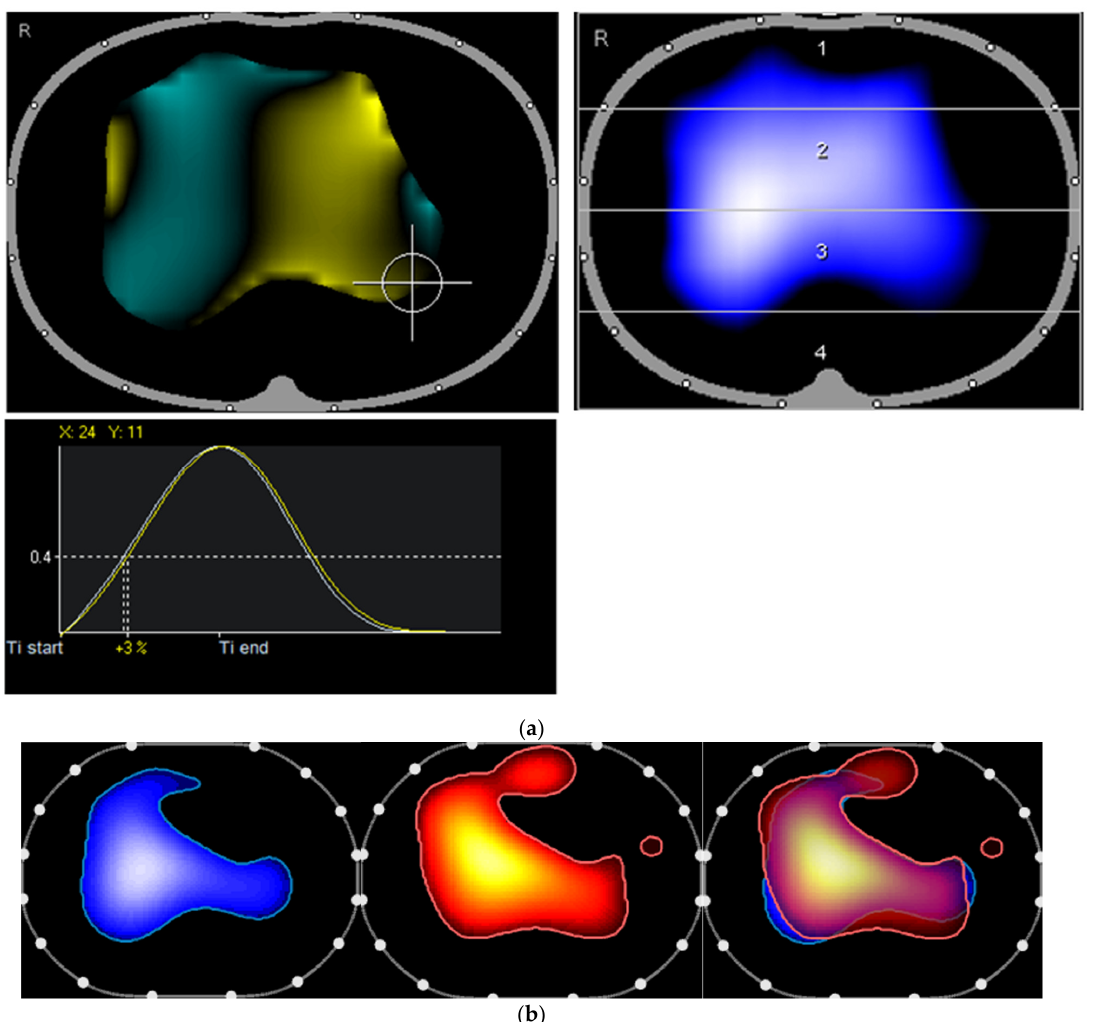
Figure 3. ( a. ) The second presentation of the patient: The ventilated area is at this time slightly in- creased with continued low ventilation (left ventral in the tidal image). The inspiratory course is more homogeneous, with only a small extent of the regional ventilation delay (left dorsal; +3%) and a lateroventrally located region that is ventilated earlier (turquoise). ( b. ) Second presentation of the patient: The right ventral region is now ventilated again. The distribution of ventilation and pulsa- tile blood flow are highly concordant.